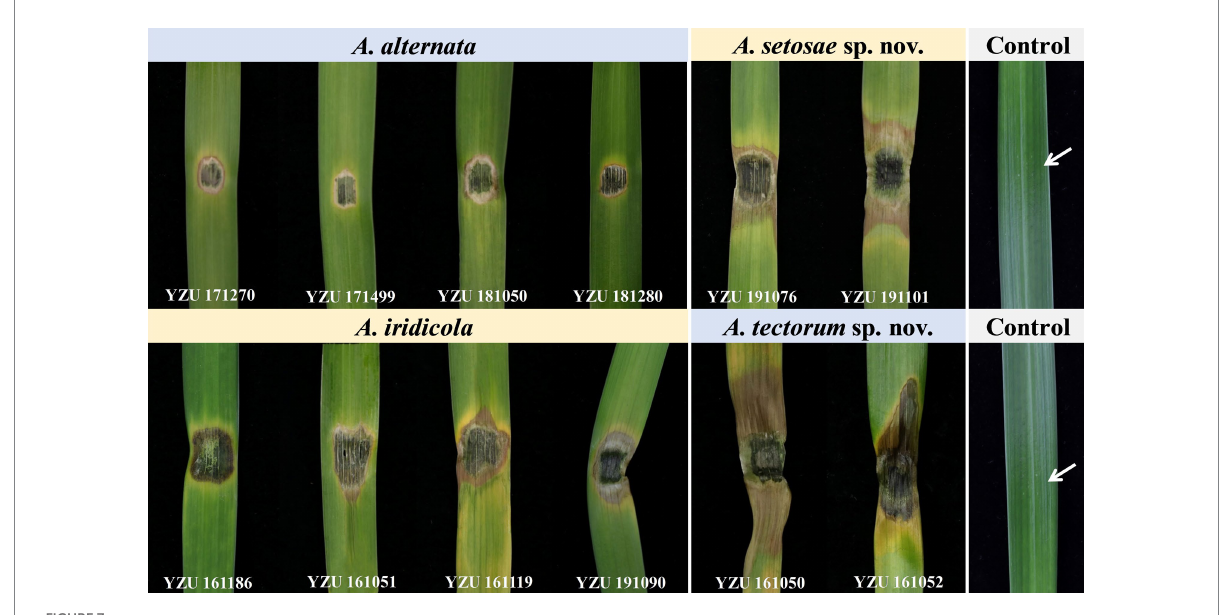
FIGURE 7 Pathogenicity of the present Alternaria species on Iris setosa